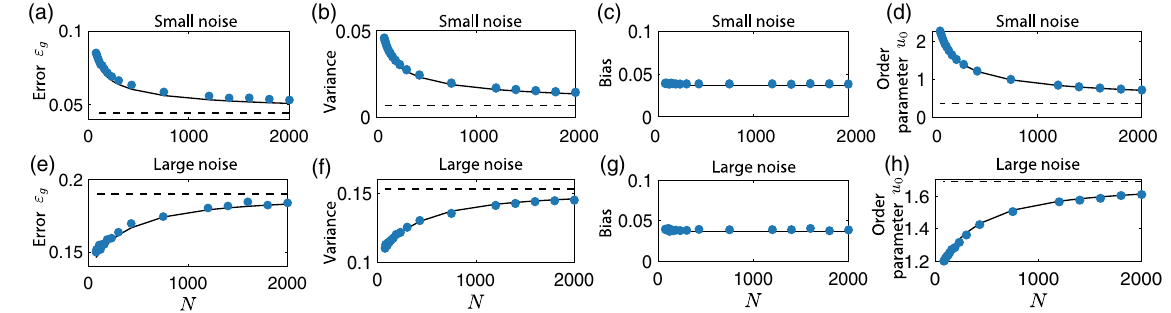
FIG. 13. Single hidden-layer ( L ¼ 1 ) ReLU network trained on the template model linear teacher example with details of the parameters in Appendix E, in the α 0 > 1 regime. (a,e) Generalization error, (b,f) variance, (c,g) squared bias of the predictor, and (d,h) the order parameter u 0 as a function of N . Black solid lines: theory. Blue dots: simulation. Black dashed lines: GP limit ( N ¼ ∞ ). (a) – (d) Results in the small-noise regime where the generalization error decreases with N . (e) – (h) Results in the large-noise regime where the generalization error increases with N .